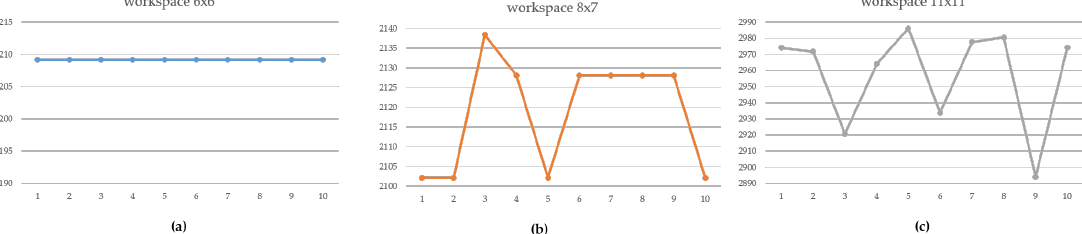
Figure 18. The costweights of 10 trials for ACO. ( a ) workspace Figure 12a, ( b ) workspace Figure 12b, ( c ) workspace Figure